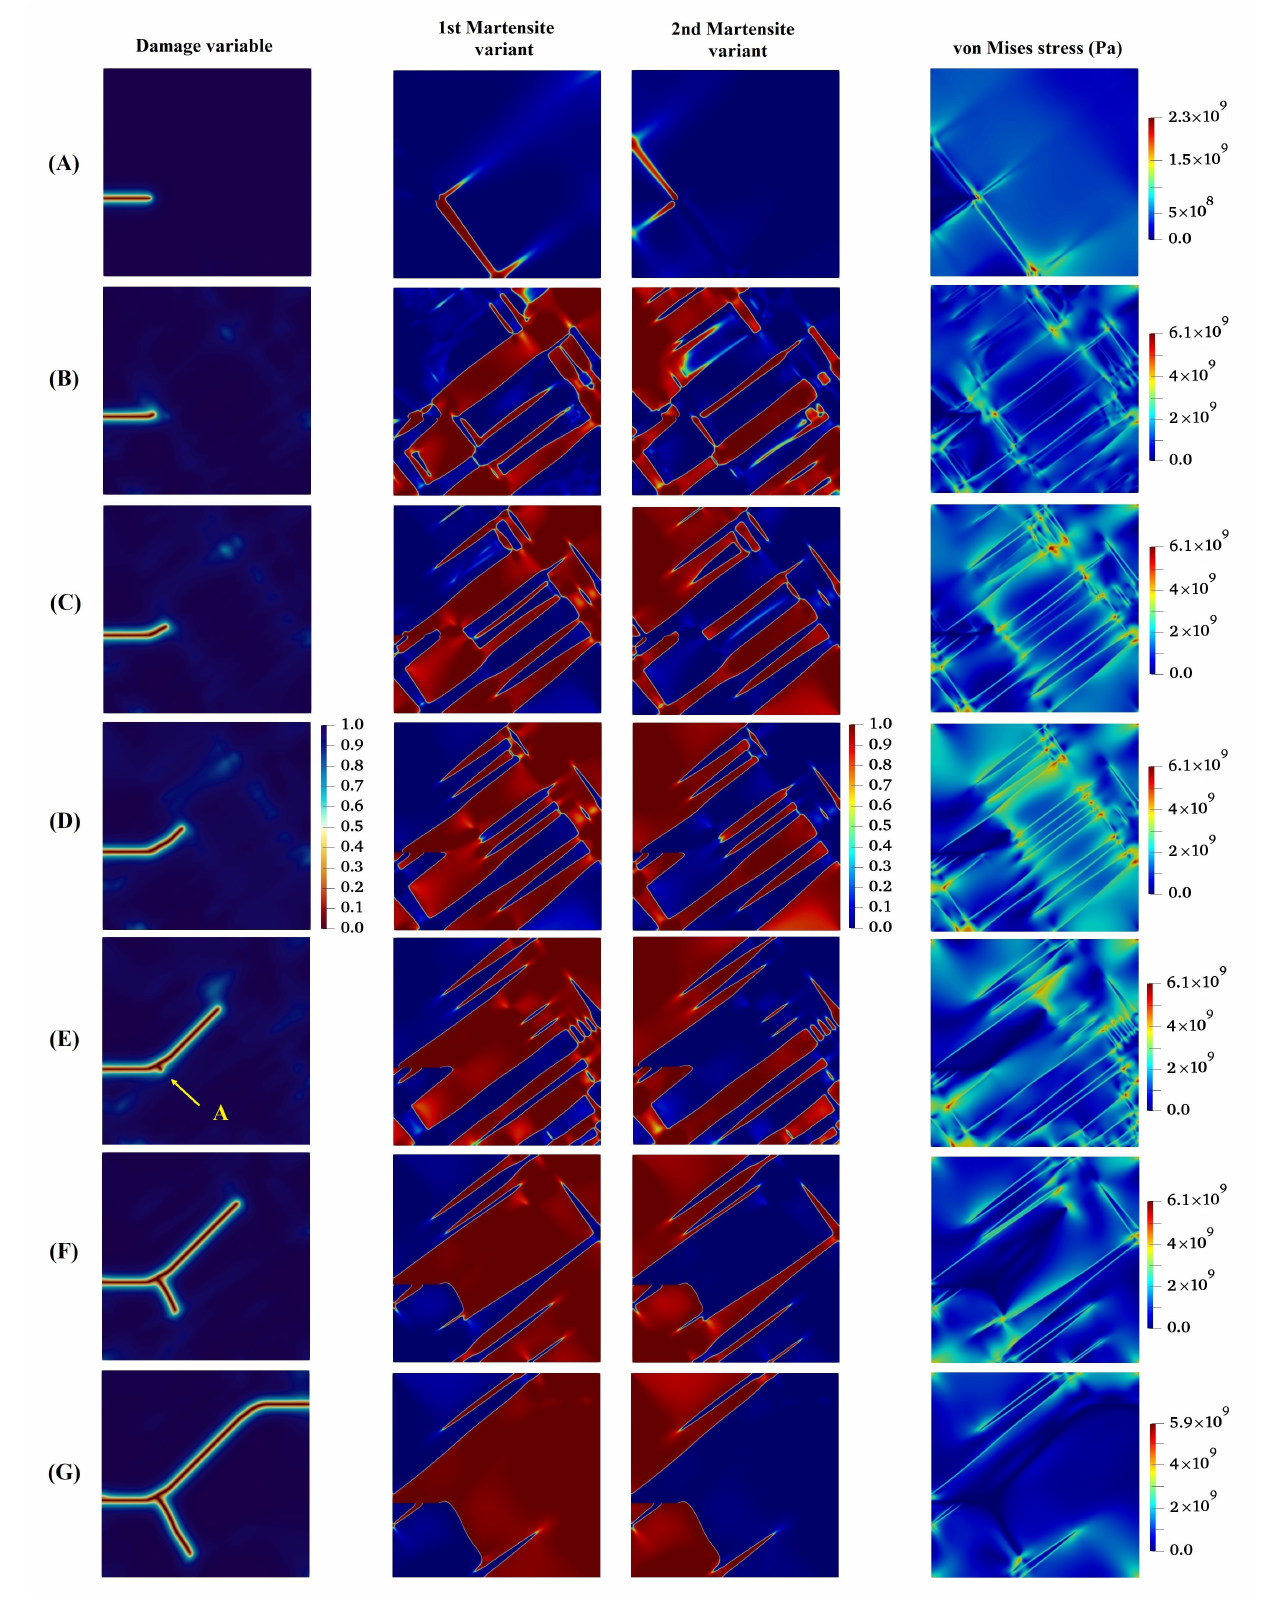
Figure 7. Evolution of damage variable, two martensite variants, and von Mises stress in the austenitic microstructure with crystal lattice orientation of 30°